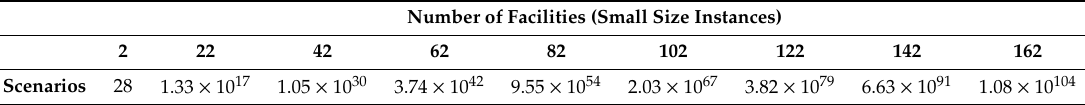
Table 6. CLITraP-HTF search space for scenarios with different number of facilities.